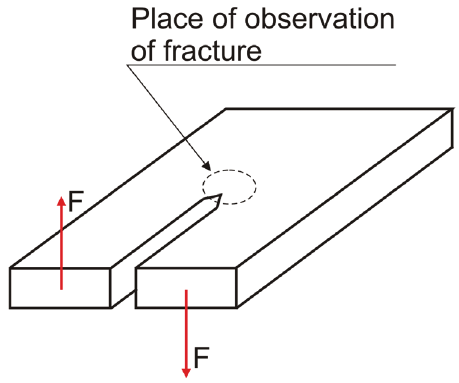
Table 1: CVD process parameters.